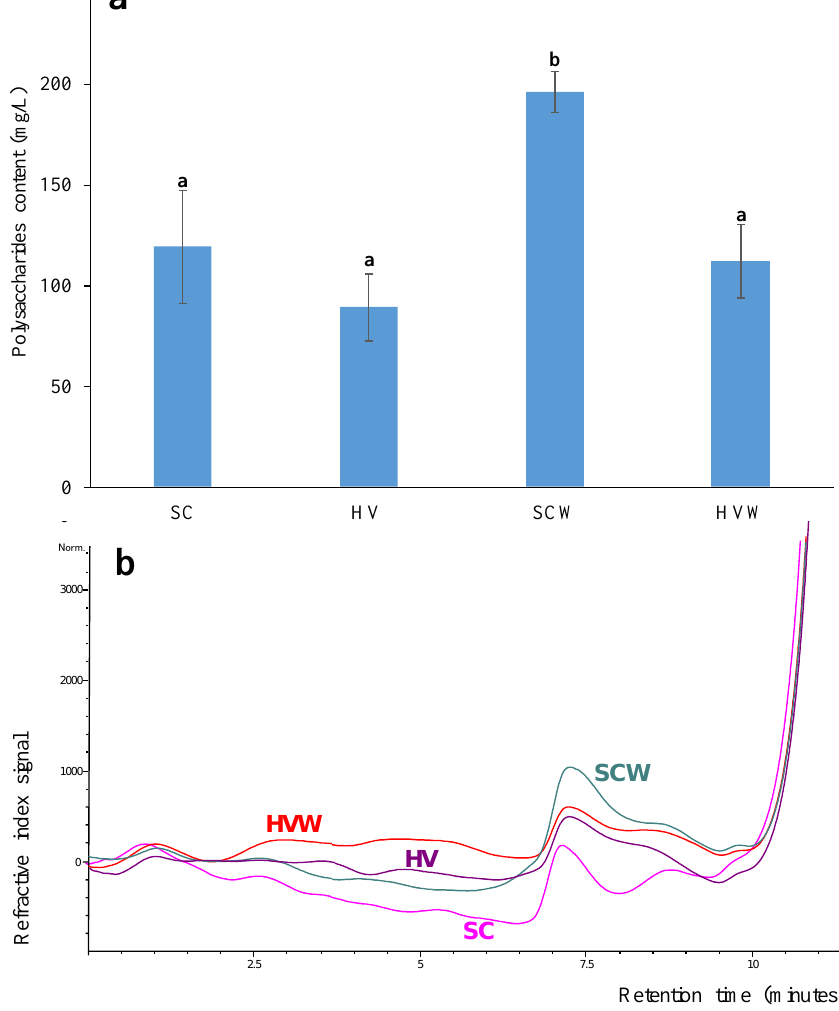
Figure 3. Polysaccharides (mg/L) ( a ) and chromatogram ( b ) measured by molecular exclusion liquid chromatography-refractive index detection (LC-RID). SC (fermentations with S. cerevisiae in stainless steel barrels); HV (fermentations with H. vineae in stainless steel barrels); SCW (fermentations with S. cerevisiae in oak barrels); HVW (fermentations with H. vineae in oak barrels). Bars with the same letter are not significantly different ( p < 0.05).